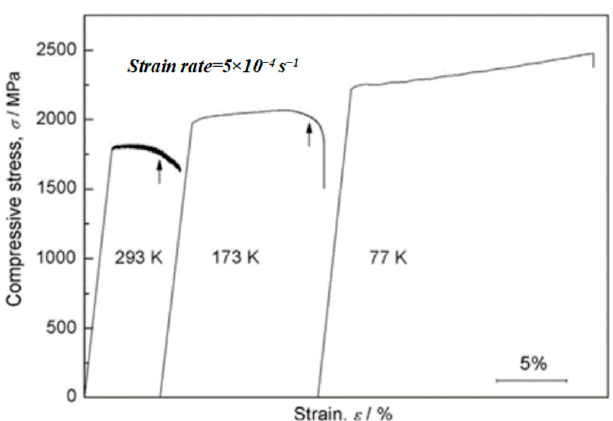
Figure 1. Nominal compressive stress–strain curves of the Zr 60 Ni 25 Al 15 BMG conducted at tempera- tures of 293, 173 and 77 K. Reprinted with permission from Ref. [6]. Copyright 2013, Elsevier.